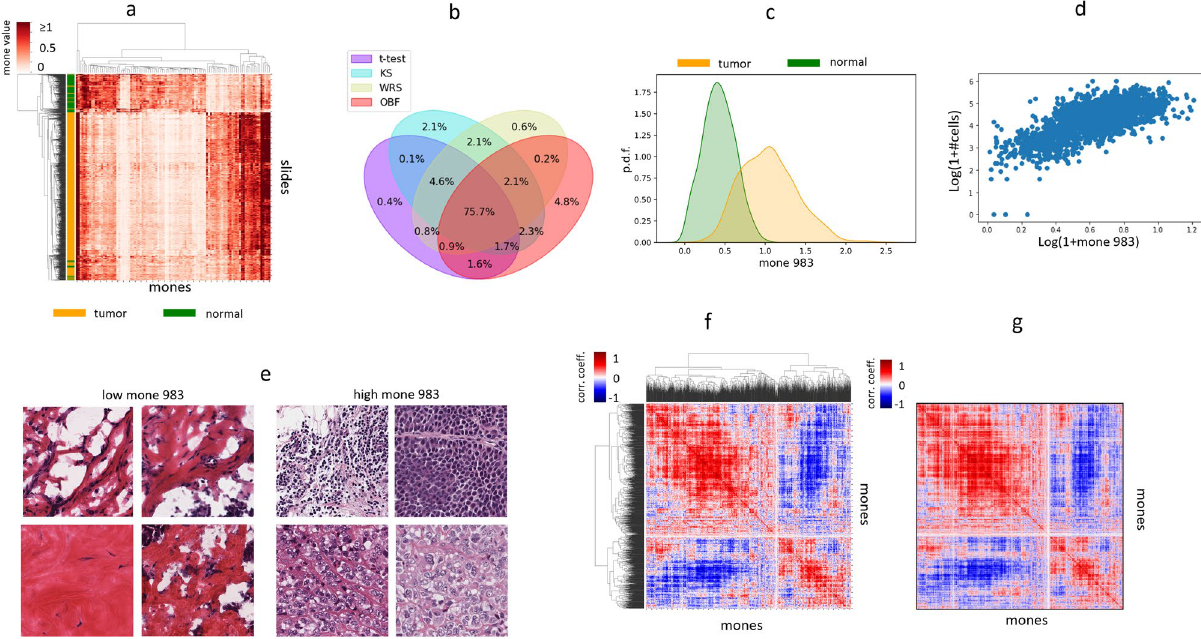
Figure 2. Individual mones and mone pairs encode and distinguish phenotypes. ( a ) Clustermap of BRCA slides using the top100 mones differentiating the slides. 100 mones are sufficient to separate frozen normal (green) from frozen tumor (orange) slides. ( b ) Venn diagram of statistically significant mones differentiating tumor from adjacent normal frozen slides, comparing different statistical tests. Venn diagrams were calculated for each cancer type, and the observed plot shows the average across all cancer types. On average the statistical tests agree on 75% of mones differentiating between tumor and normal slides. ( c ) Probability density function of mone 983 among frozen tumor (orange) and adjacent normal (green) BRCA slides. ( d ) Log-normalized scatter plot of slide level mone 983 and cellpose 57 estimates of cellularity across BRCA frozen slides. ( e ) Example tiles from slides with extreme mone 983 values (high and low). ( f ) Cluster map of the mone-mone correlation matrix of LUAD tumor slides, demonstrating that many mones pairs are highly correlated. ( g ) Mone-mone correlation matrix of LUSC slides, with mones ordered identically to the Fig. 1f cluster